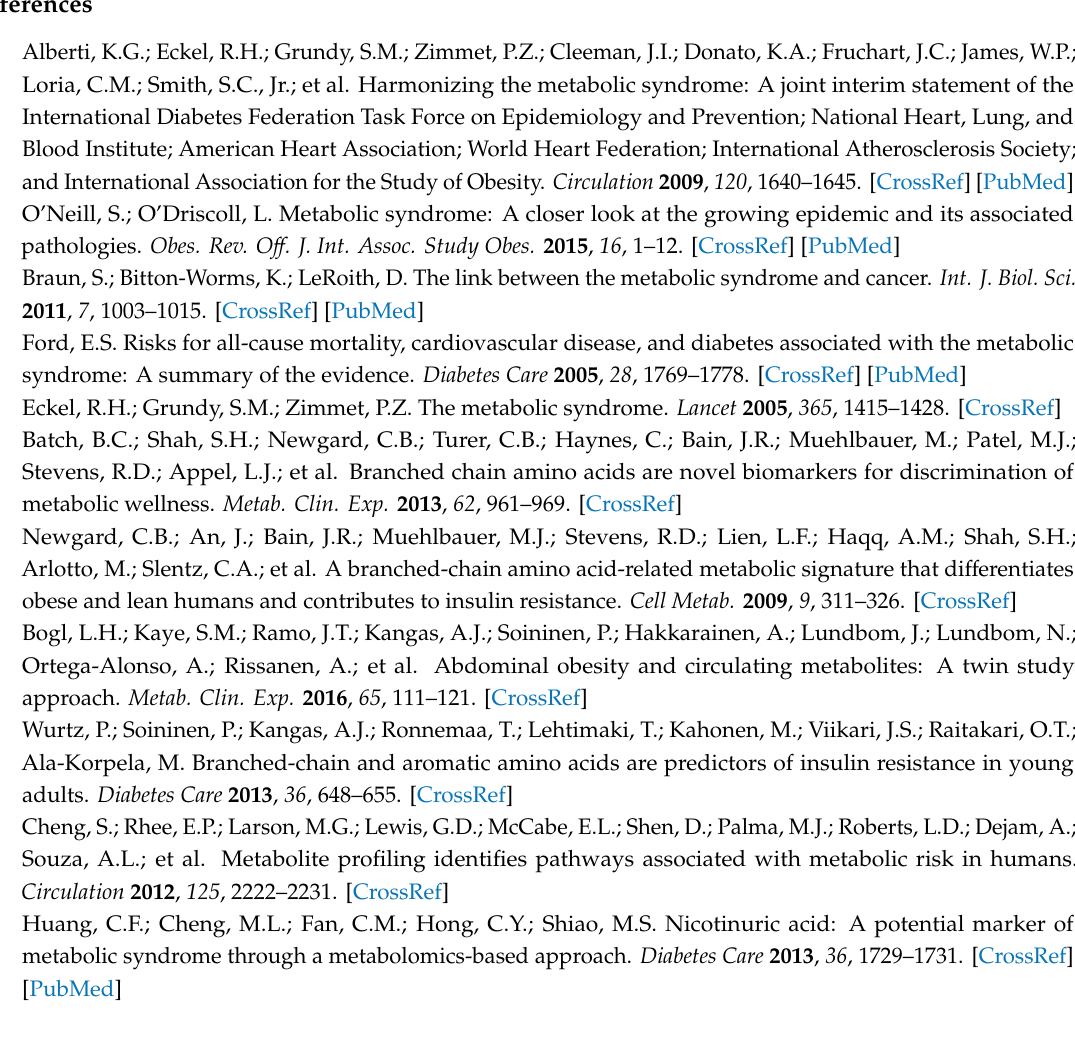
Table S1: Serum glucose and insulin concentrations. Table S2: Serum lactate concentration. Table S3: Summary of model characteristics from PLS-DA multivariate analysis, concerning serum samples. Table S4: Summary of p values and e ff ect sizes (ES) for all significant e ff ects from the univariate statistical analysis. Figure S1: Score plots for the valid PLS-DA models of pairwise comparisons of exercise modes at 1 h. Figure S2: Score plots for the valid PLS-DA models of pairwise comparisons of exercise modes at 2 h. Figure S3: Score plots for the valid PLS-DA models of pairwise comparisons of di ff erent time points for HIIE. Figure S4: Score plots for the valid PLS-DA models of pairwise comparisons of di ff erent time points for